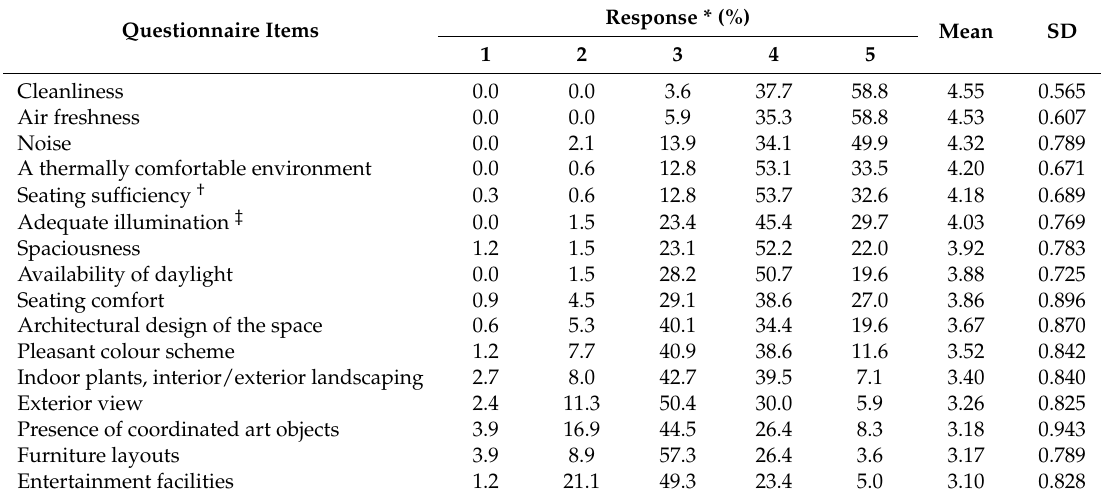
Table 2. Descriptive analysis.